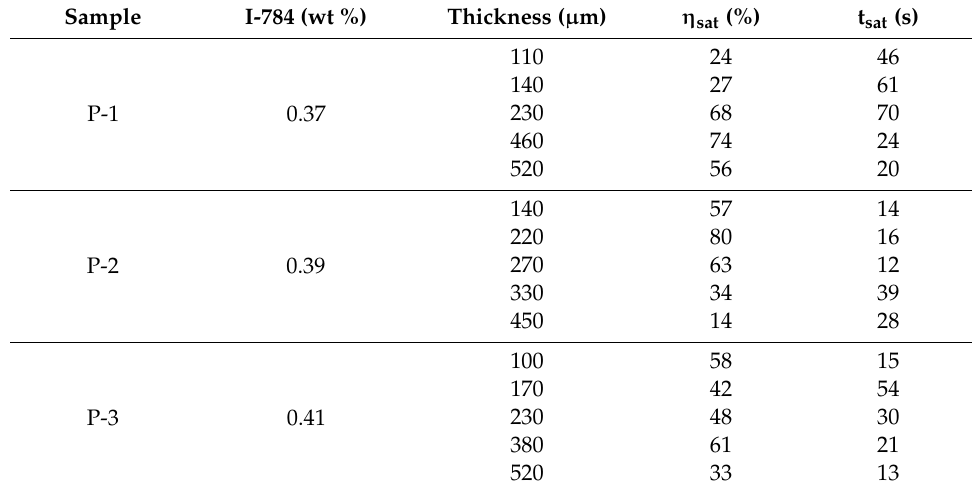
Di ff raction e ffi ciency and response time at saturation under varying photo-initiator